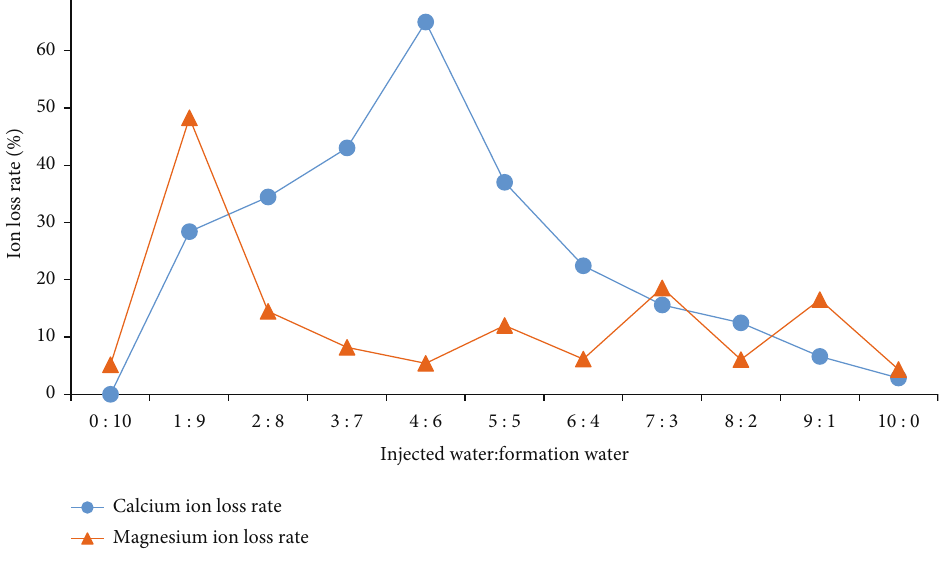
Figure 4: Water quality compatibility data chart.